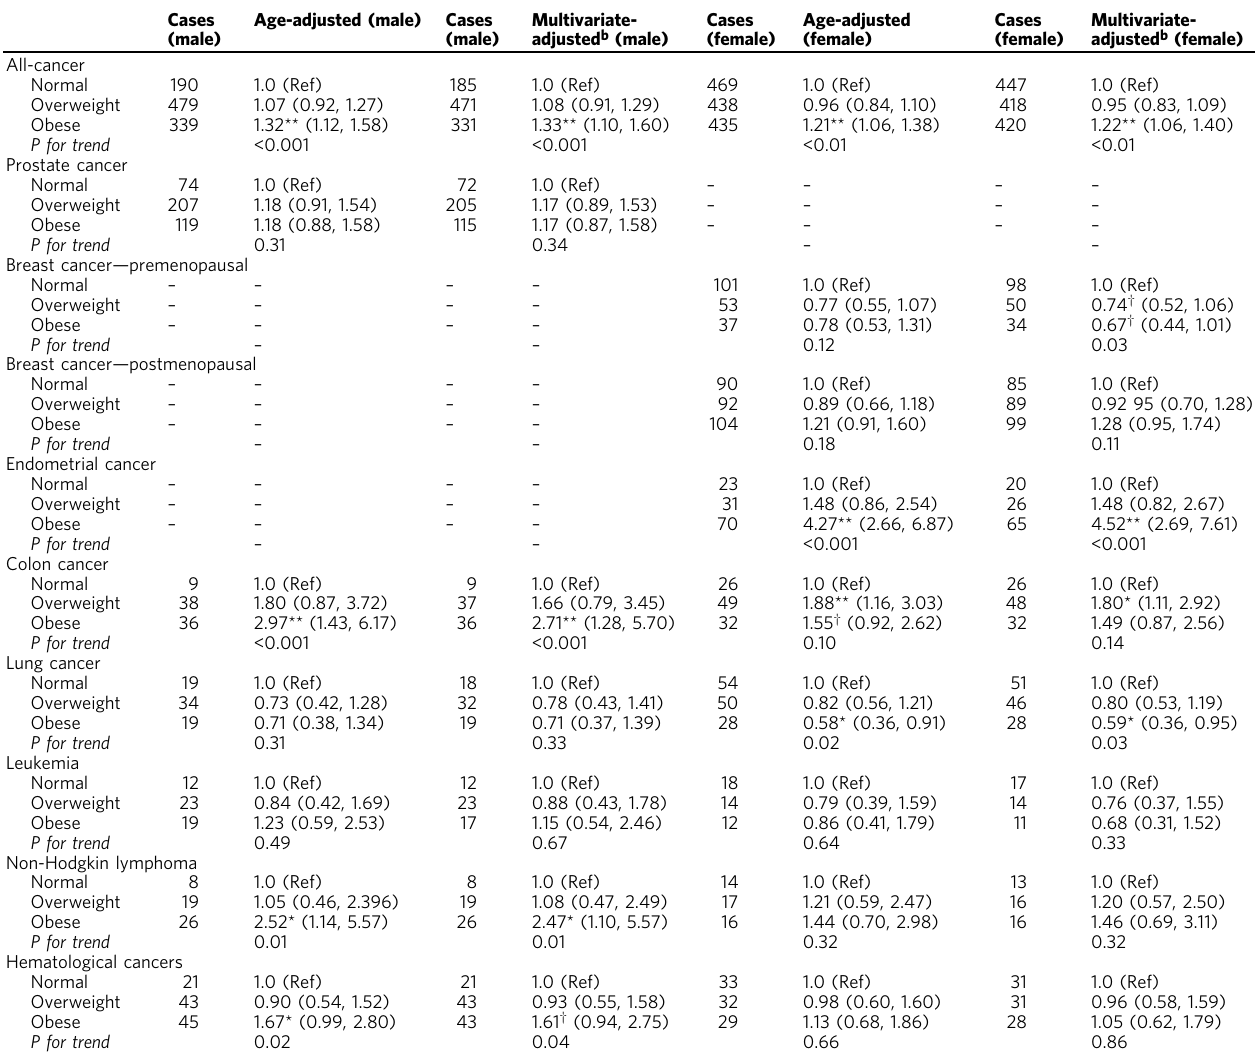
Table 2 Results from analyses of BMI categories a and cancer incidence among ATP participants with a BMI ≥ 18.5 kg/m